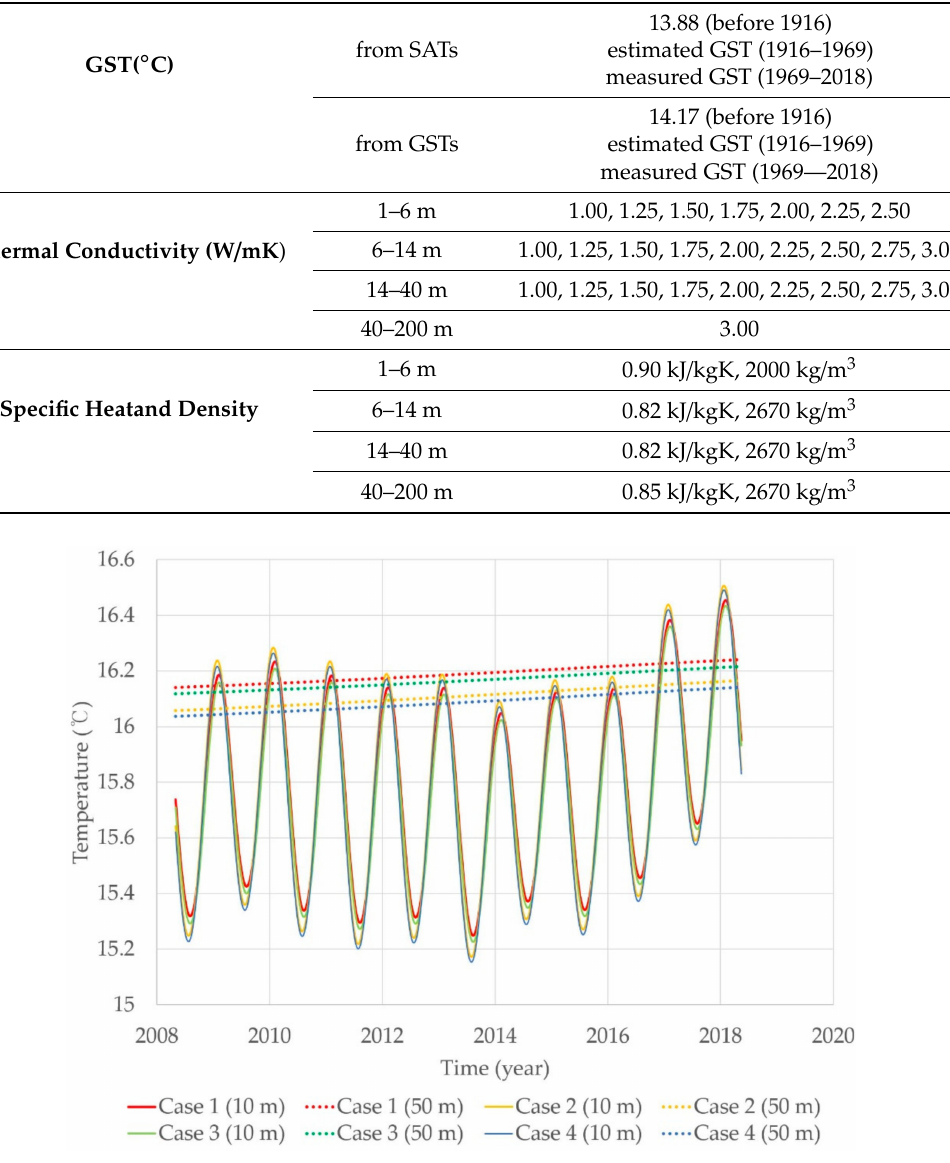
Figure 6. The simulation results of four cases considering temperature changes at depths of 10 and 50 m due to changes in the GST from 2008 to